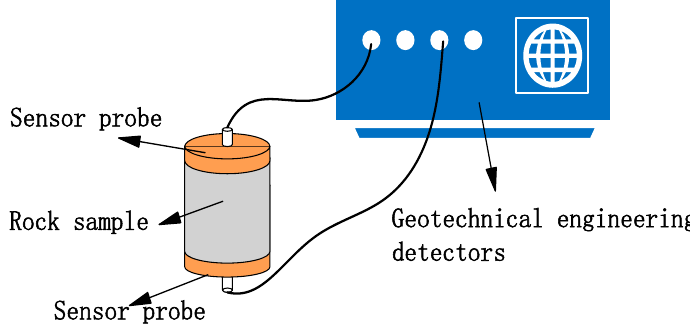
Figure 3. Schematic diagram of the P-wave velocity test.